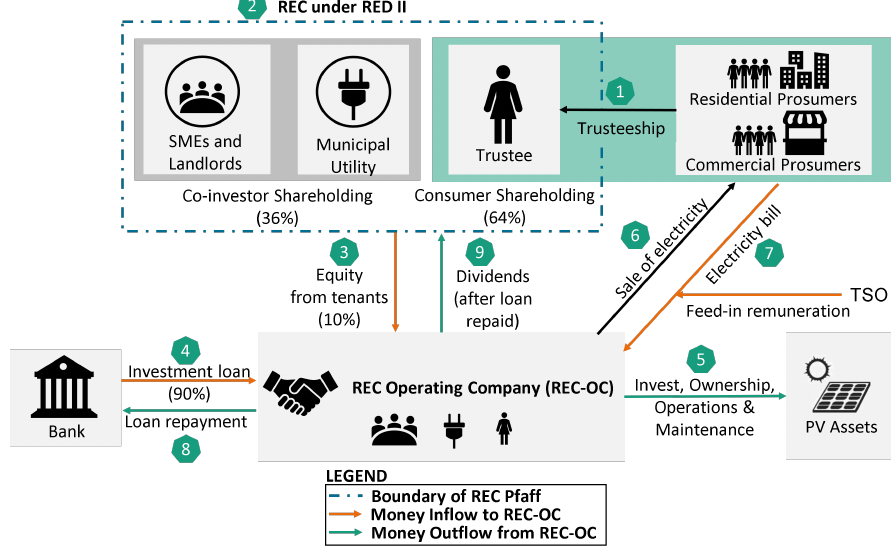
Figure 3. Organizational structure of REC Pfaff. The numbers represent the steps in the formation and operation of REC